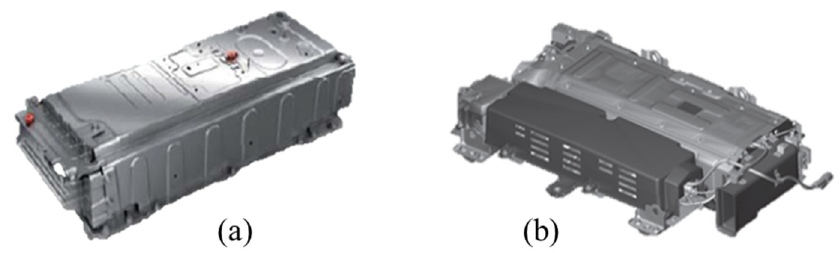
Table 1. Layout, types, and parameters of the studied power battery packs.